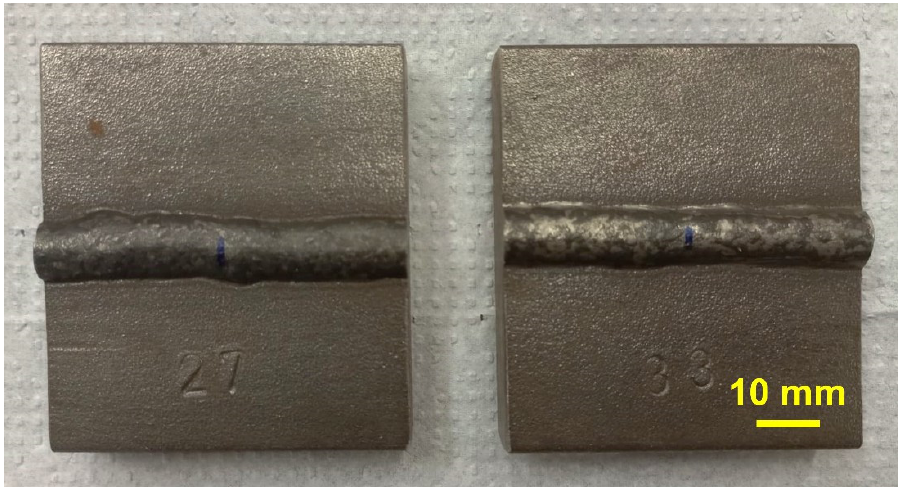
Figure 1. Macroscopic image of two bead-on-plate clads produced by pulsed fluxed core arc welding process (FCAW).